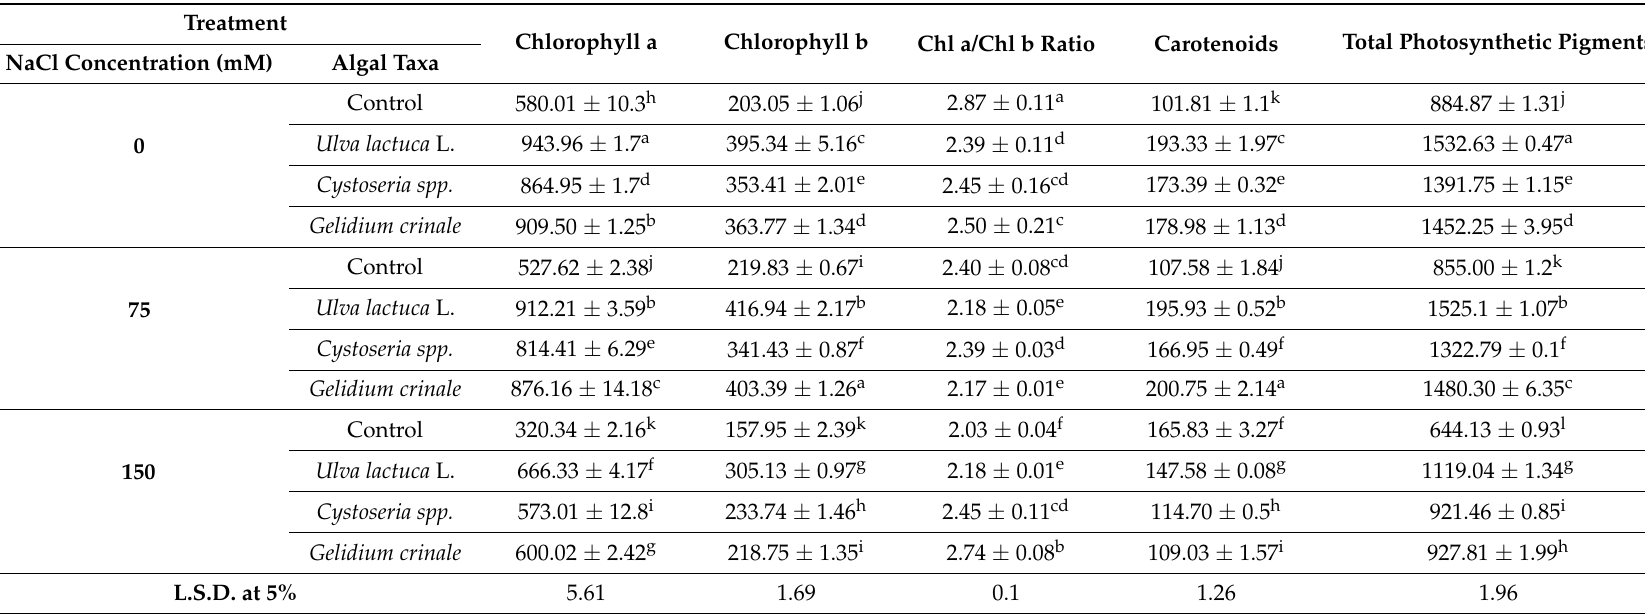
Table 4. The impact of Ulva lactuca L., Cystoseria sp., and Gelidium crinale soil treatment on the photosynthetic pigment content of canola plants (at the vegetative